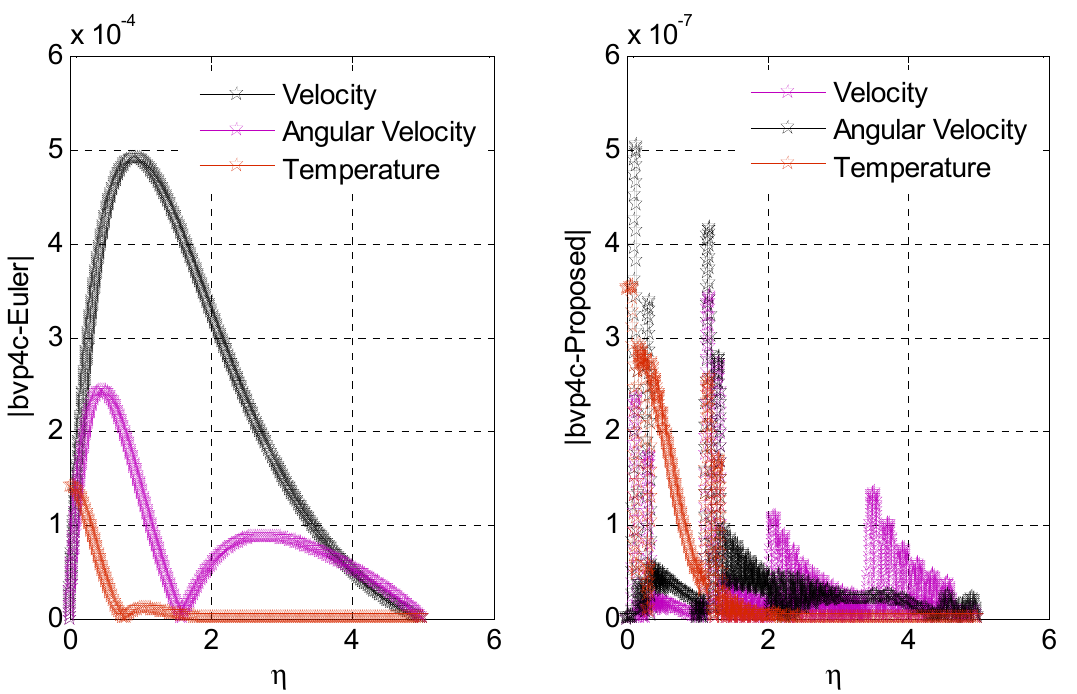
Figure 3. Comparison of the proposed scheme with the forward Euler method for velocity, angular velocity, and temperature profiles using G = 1, K b = 0.1, λ = 0.1, F r = 0.1, P r = 7, R d = 0.1,Q = 0.1, Bi = 0.1, and N = 2040.